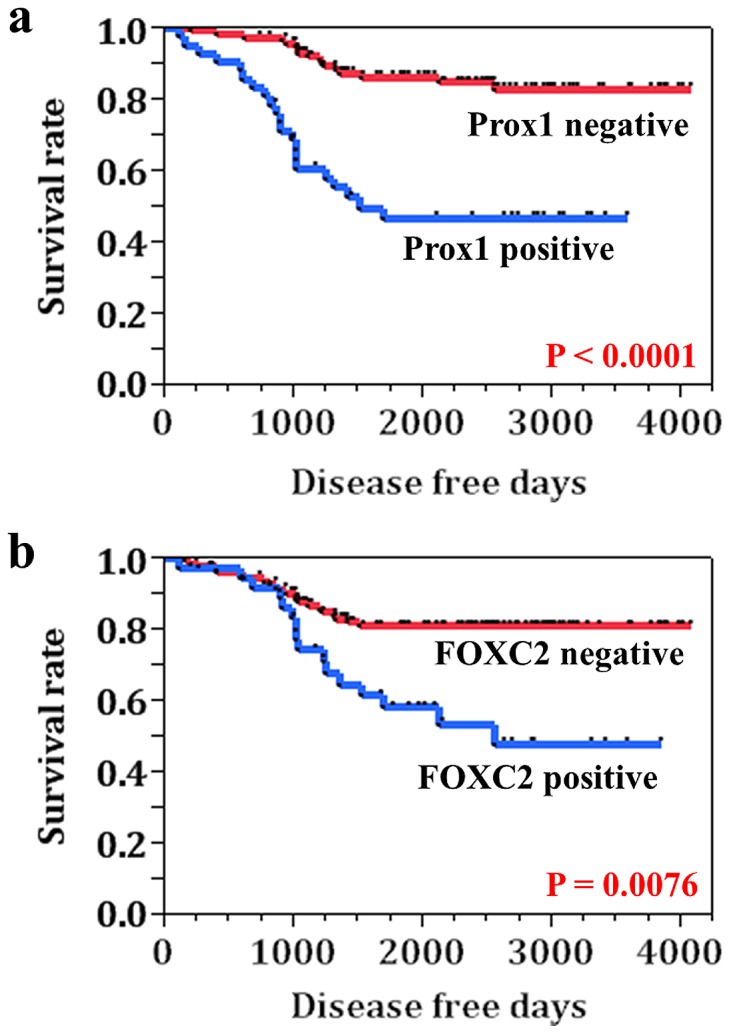
Disease free survival in OSCC cases.
a, Prox1-positive cases had significantly reduced disease-free survival compared to the Prox1-negative patients (P<0.0001). b, The patients with FOXC2-positive tumors also had significantly poor prognosis than those with FOXC2-negative tumors (P = 0.0076).